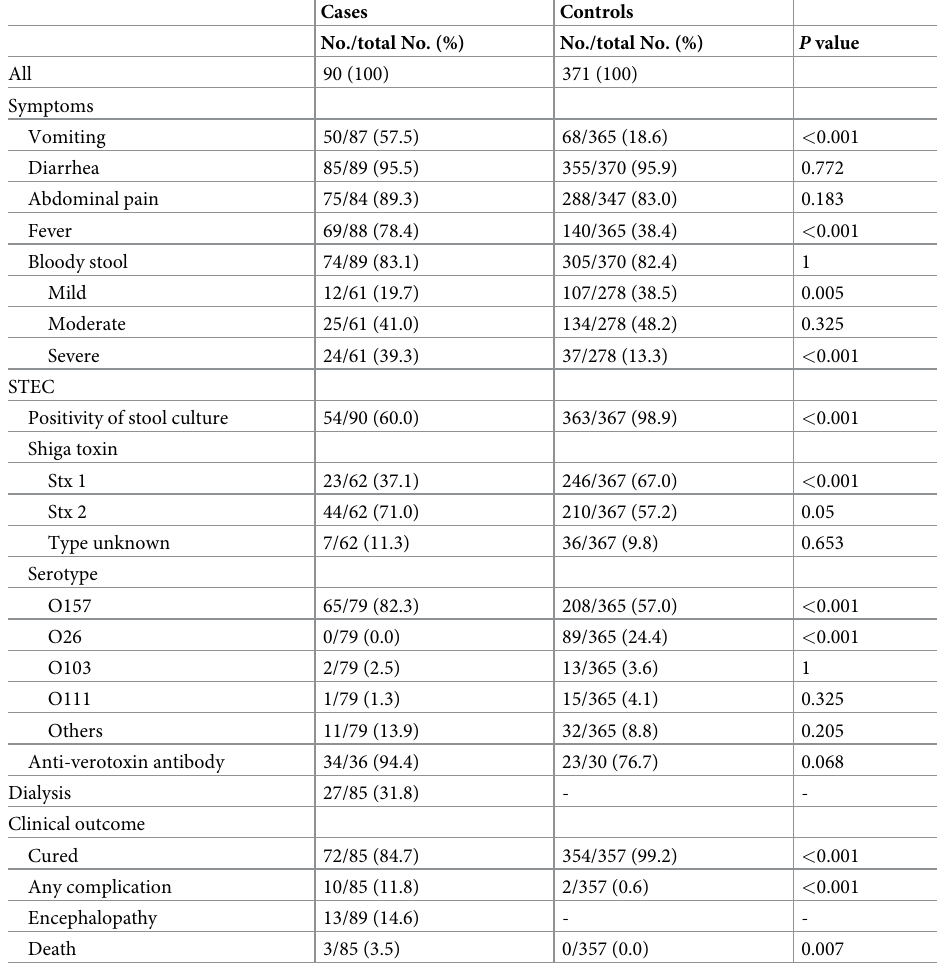
Table 2. Baseline characteristics of the cases and controls in the analysis dataset.